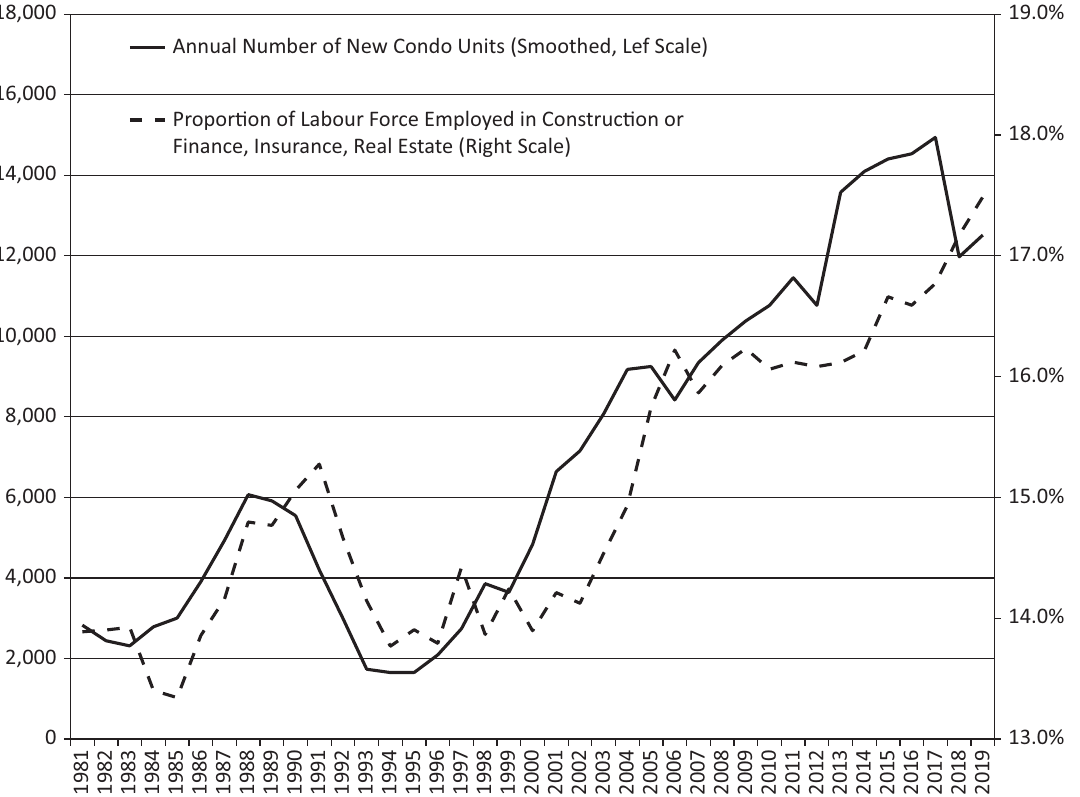
Figure 5. Annual new condo units in the City of Toronto compared to Toronto CMA jobs in the FIRE sector, 1981–2019. Source: Updated from Rosen and Walks (2015), and calculated by the authors using condo data provided by CMHC (2022), employment data from Statistics Canada (1981, 1991, 2001, 2006, 2011, 2016, 2022b, 2022c) as well as the City of